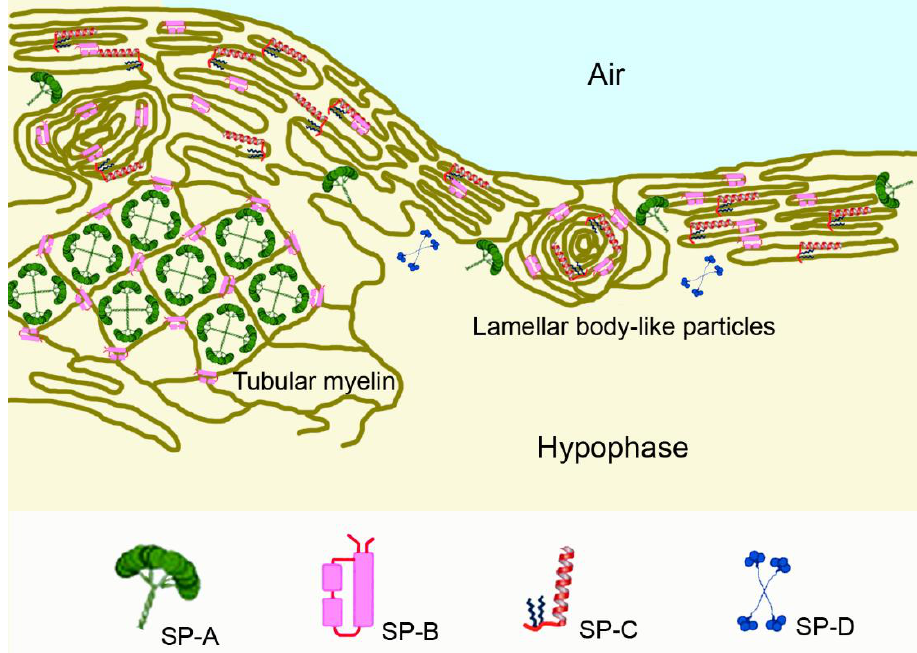
Figure 4. Pulmonary surfactant forms a lipid layer at the air–liquid interface above the hypophase (epithelial lining fluid) that covers the epithelial cell surface. Surfactant protein (SP)-B is important for formation and assembly of lamellar body-like particles, which can directly adsorb to the interface for surface film formation. Lamellar bodies secreted from alveolar epithelial type II cells (not shown in the figure) can unravel to form tubular myelin or rapidly move through a continuous network of surfactant membranes. During exhalation, the surfactant surface folds and SP-C plays a role in stabilizing the lipid membranes. Multilayered surfactant membranes form a reservoir for volume expansion of the alveolus upon inhalation. SP-A is integrated in a lattice of tubular myelin and binds simultaneously to different membranes, whereas SP-D exists as mainly soluble in the hypophase.